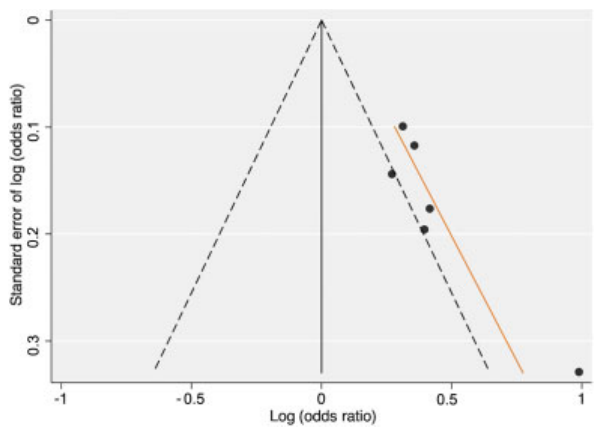
Fig. 3 Funnel plot of studies included in meta-analysis investigating the risk of ischemic stroke per 5 µmol/L increase in